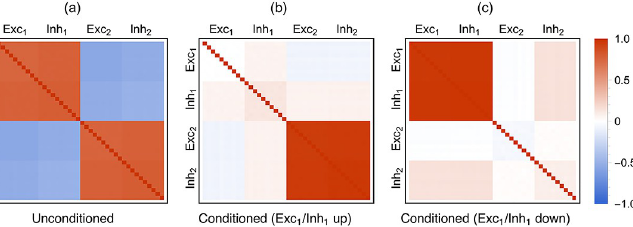
Fig 12. Correlation structure of the original bistable network. Panel (a) reveals that neurons are positively correlated within the same group, but negatively correlated across groups. This shows that the correlation structure of the metastable dynamics is primarily shaped by stochastic switches between up and down states. Panels (b) and (c) show the correlation structure of the same dynamics but conditioned on (b) Group 1 being up or (c) Group 1 being down. This shows that up-state neurons are weakly correlated, whereas down-state neurons are strongly correlated for receiving strong, shared inhibitory inputs. The correlations are estimated from simulated data, where we run the event-driven simulation until 400000 spiking events for the entire network are accumulated. We record the time series of the internal variables x i . The unconditioned correlations are computed by Cor( x i , x j ) = Cov( x i , x j )/(Std( x i )Std( x j )). The conditioned correlations are computed using the corresponding time series components (up/down state) detected and cropped from the whole time series. Parameters: μ = 1.5, μ = 4.0, a = ln(100)/20 � 0.23, h = 1 Hz, τ = 10 ms. e i